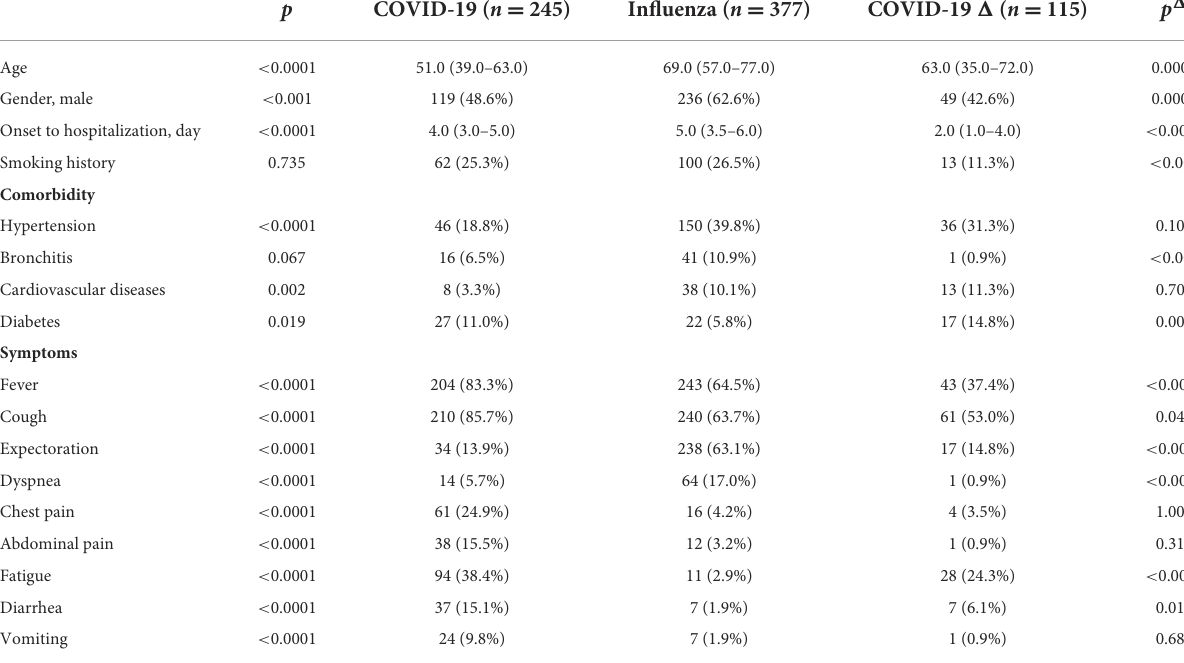
TABLE 1 Demographic data, medical history, and clinical symptoms of 377 patients with influenza vs. 245 patients with COVID-19 infected with the wild-type SARS-CoV-2 or 115 patients with COVID-19 infected with the delta variant SARS-CoV-2 upon hospital